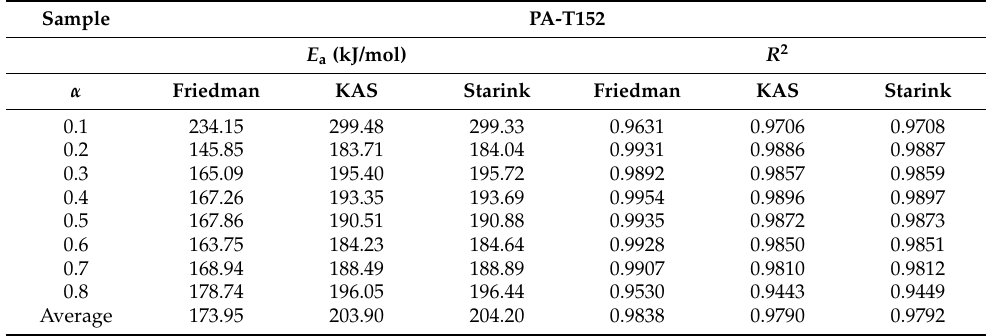
Table 4. E a and R 2 values of PA-T152 were obtained through different